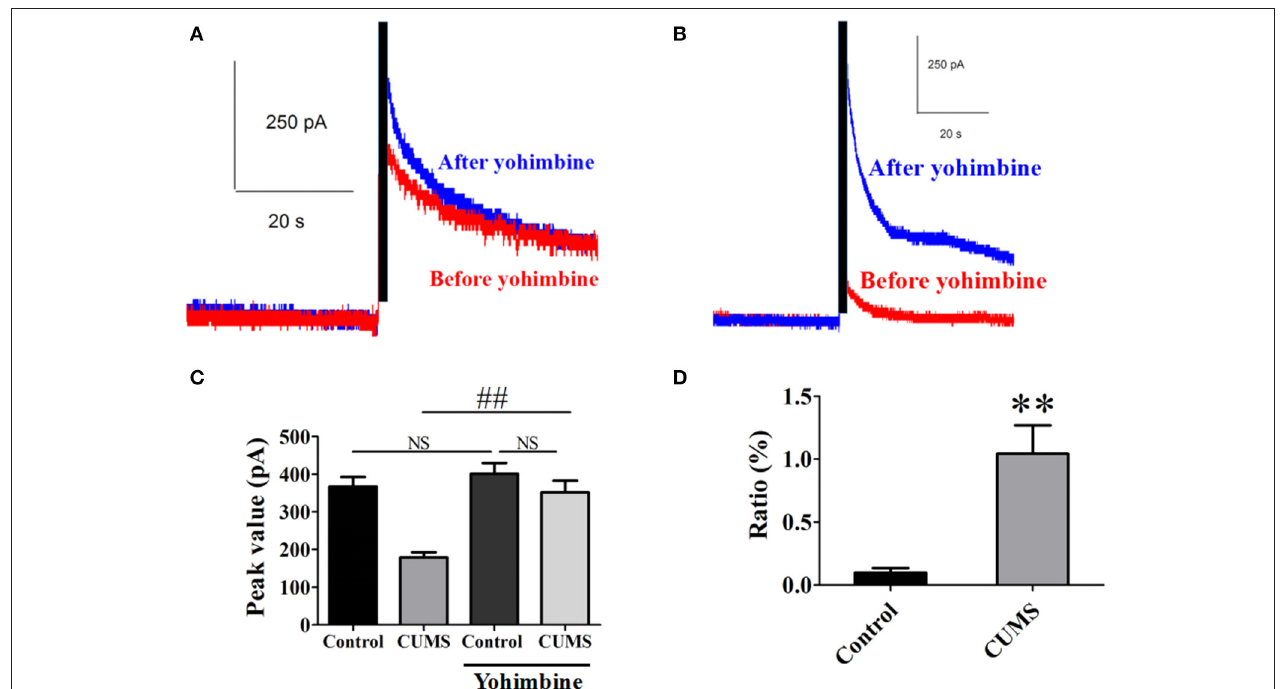
FIGURE 2 | Intraperitoneal injection of yohimbine potentiated elicited NE release signal in the CUMS rats. (A) Representative raw data of typical NE release signals recorded in the control rats before and after yohimbine. (B) Representative raw data of typical NE release signals recorded in the CUMS rats before and after yohimbine. (C) Yohimbine significantly increased the peak value of NE in the PVN of the CUMS rats, but no significant difference was observed in the control rats. (D) The ratio of increase in the peak value of NE signal was significantly amplified after administration of yohimbine in the CUMS rats compared to that in the control rats. The ratio: [(after-before)/before yohimbine]. ** p < 0.01 vs. the control rats, ## p < 0.01 vs. before yohimbine administration in the CUMS group. NS represents no